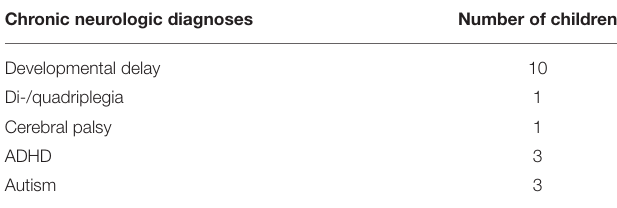
FIGURE 2 | Final Visual Acuity Distribution (Chart Readers) among patients with APROP treated with IVB.